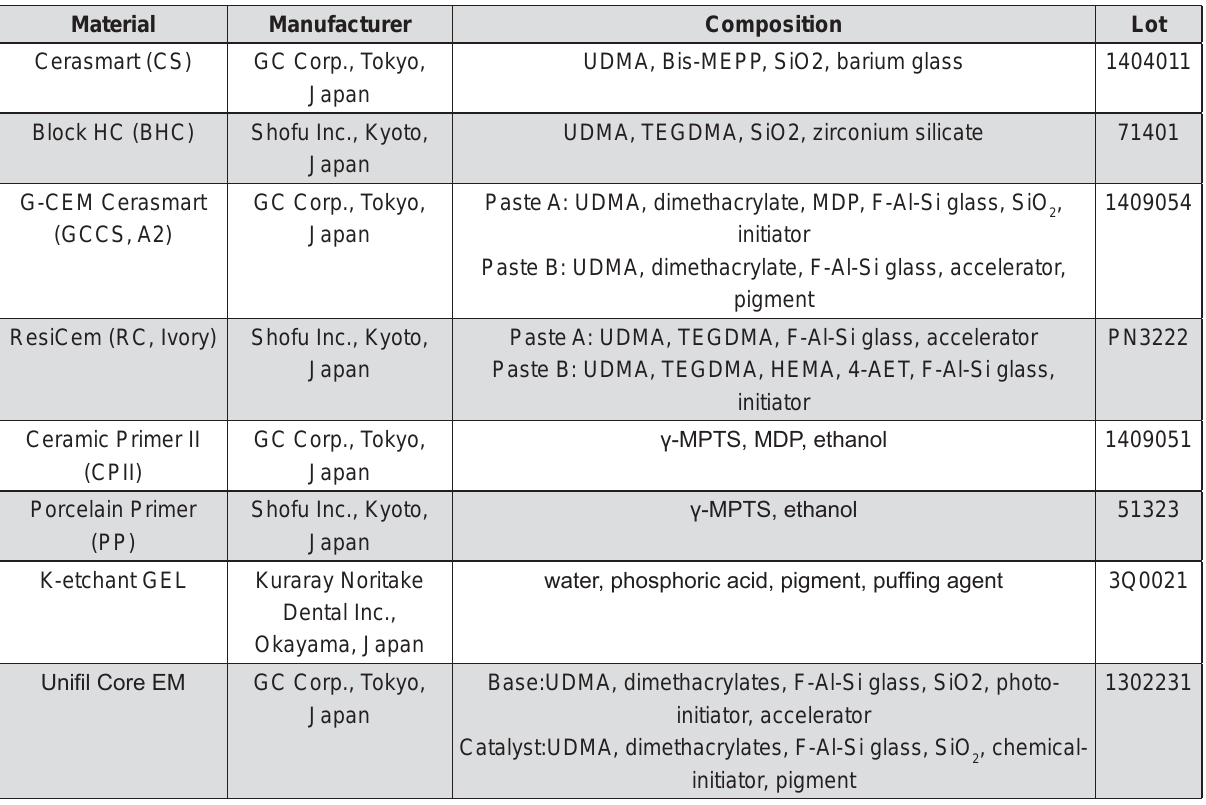
Figure 1- CAD/CAM composites, resin cements, and ceramic primers used in this